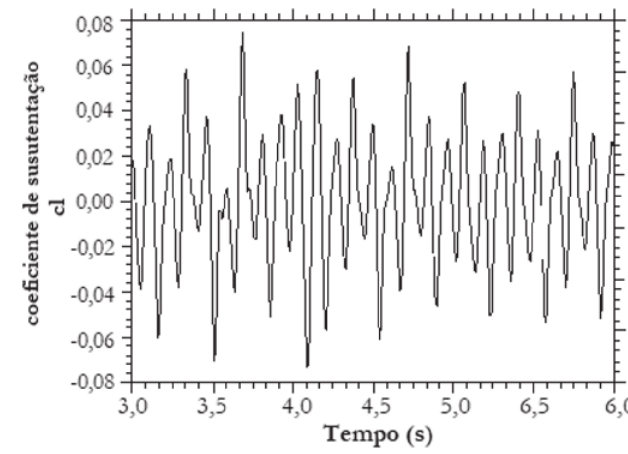
Coeficiente de sustentação sobre o Pórtico x